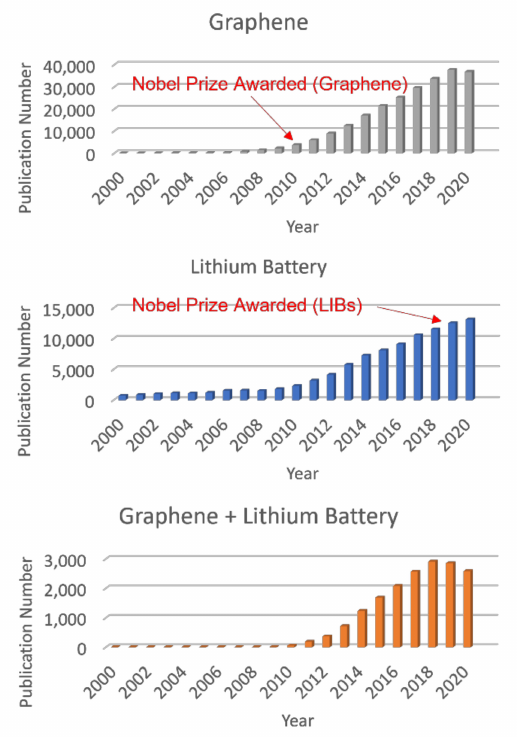
Figure 1. The number of academic publications by year using the keywords graphene ( up ), lithium battery ( middle ), and graphene + lithium battery ( bottom ) (source: Web of Knowledge, 18 May